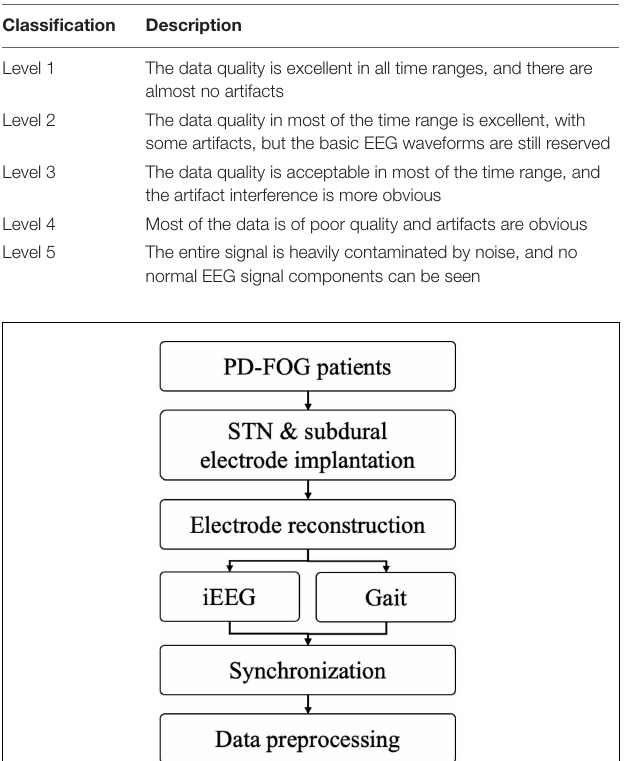
TABLE 2 | Classification of data quality.